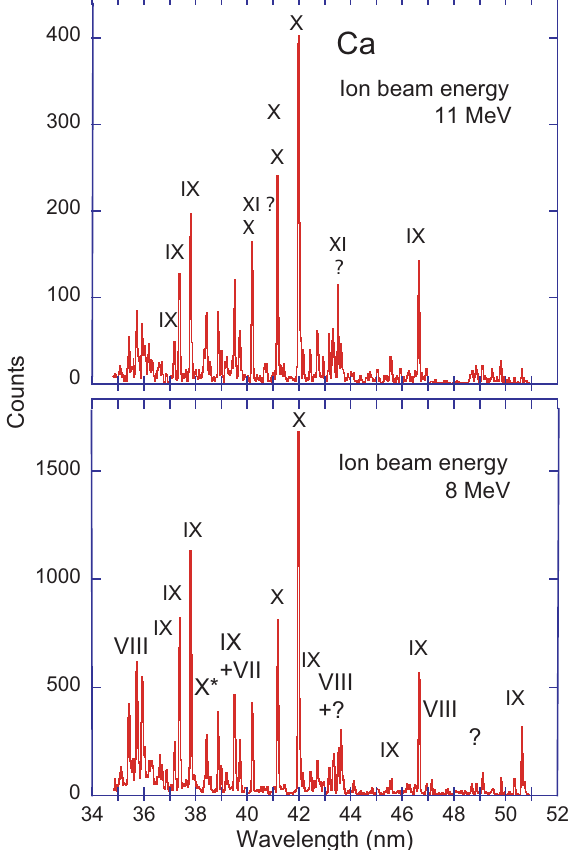
Figure 2. Ca beam-foil spectra obtained at ion beam energies of 8 and 11MeV, respectively. In order to avoid visual clutter, the spectrum numbers are indicated only for some prominent lines and line groups. Line width